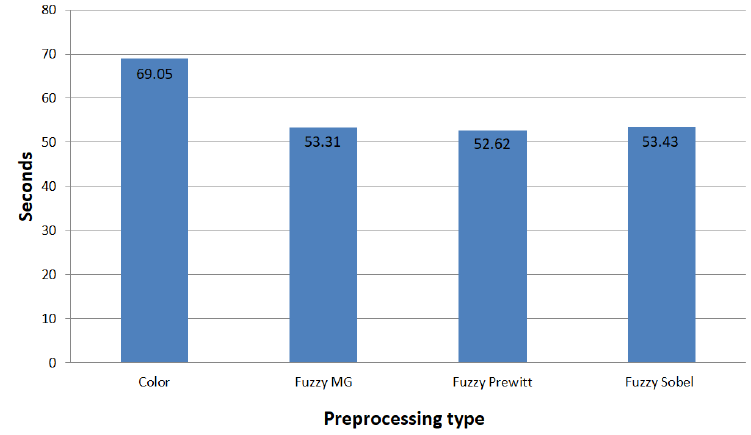
Figure 12. Average training time per model in seconds for CNN-I.